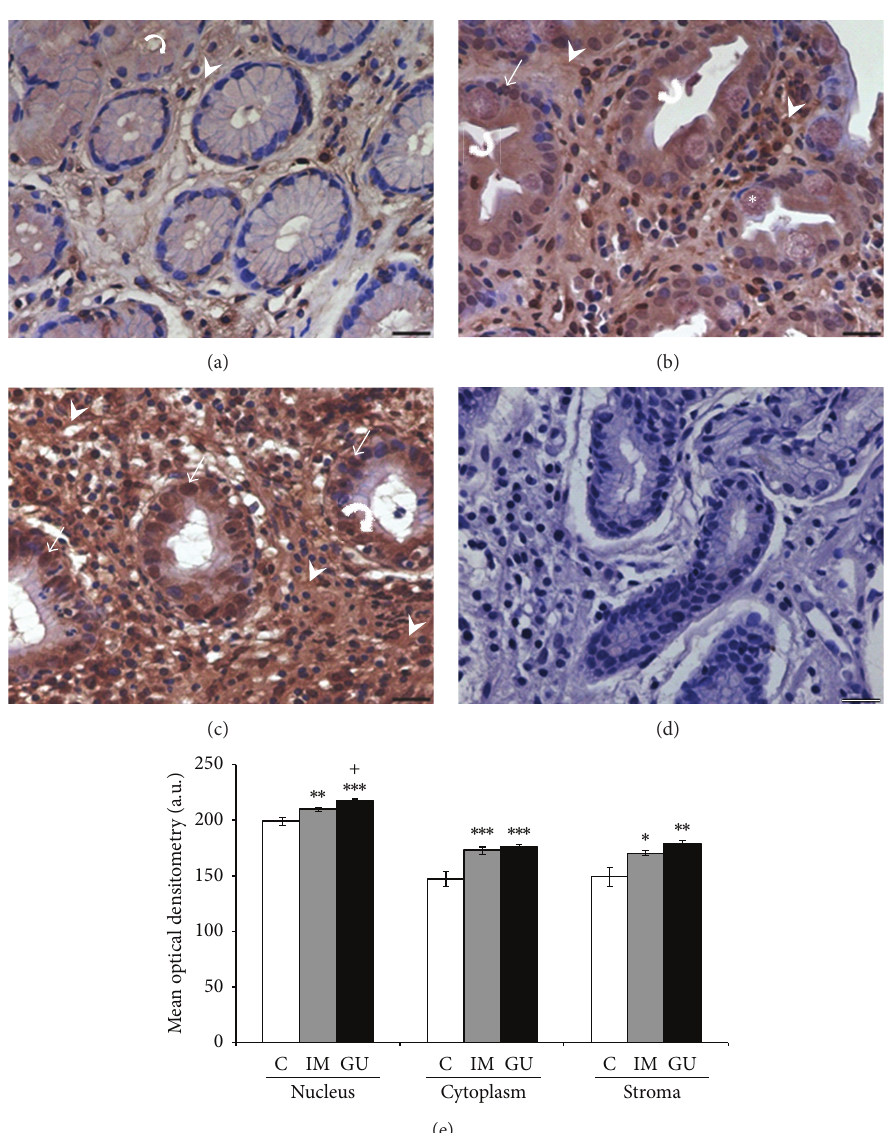
Figure 2: Expression of annexin-A1 protein in gastric mucosa (a–c). (a) Expression of AnxA1 in normal mucosa (C), predominantly in the cytoplasm of epithelial cells (curved arrow) and stroma (arrowhead). (b) Increased expression after intestinal metaplasia (IM) in the nucleus (arrow), cytoplasm (curved arrow), and stromal region (arrowhead). (c) Higher AnxA1 expression can be observed in peripheral area of gastric ulcer (GU) especially in stroma (arrowhead) and epithelial cells (curved arrow and arrow). (d) Absence of immunoreactivity in the reaction control. Asterisk: goblet cell. Hematoxylin of Harris counterstain. Bar: 20 𝜇 m. (e) Densitometry analyses (mean ± SE). ∗ 𝑃 in relation to C ( ∗ 𝑃 < 0.05 ; ∗∗ 𝑃 < 0.01 ; ∗∗∗ 𝑃 < 0.001 ); + 𝑃 < 0.05 in relation to IM. a.u.: arbitrary